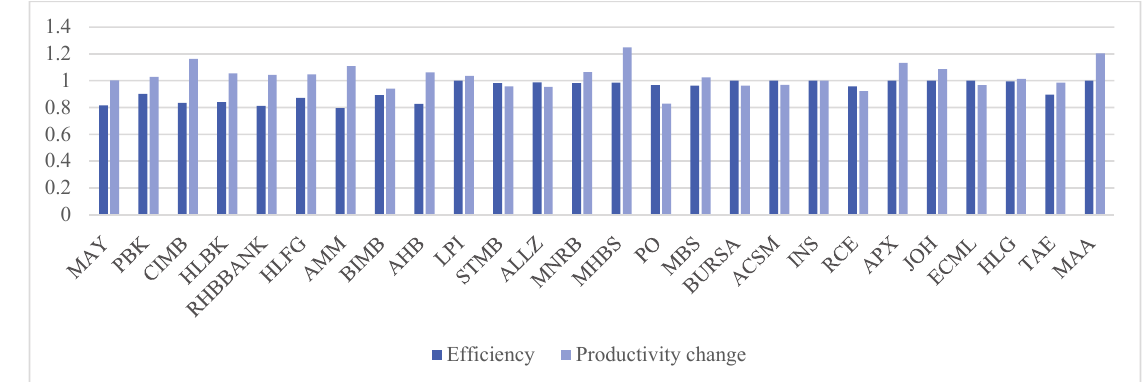
Fig. 3. Efficiency and Productivity